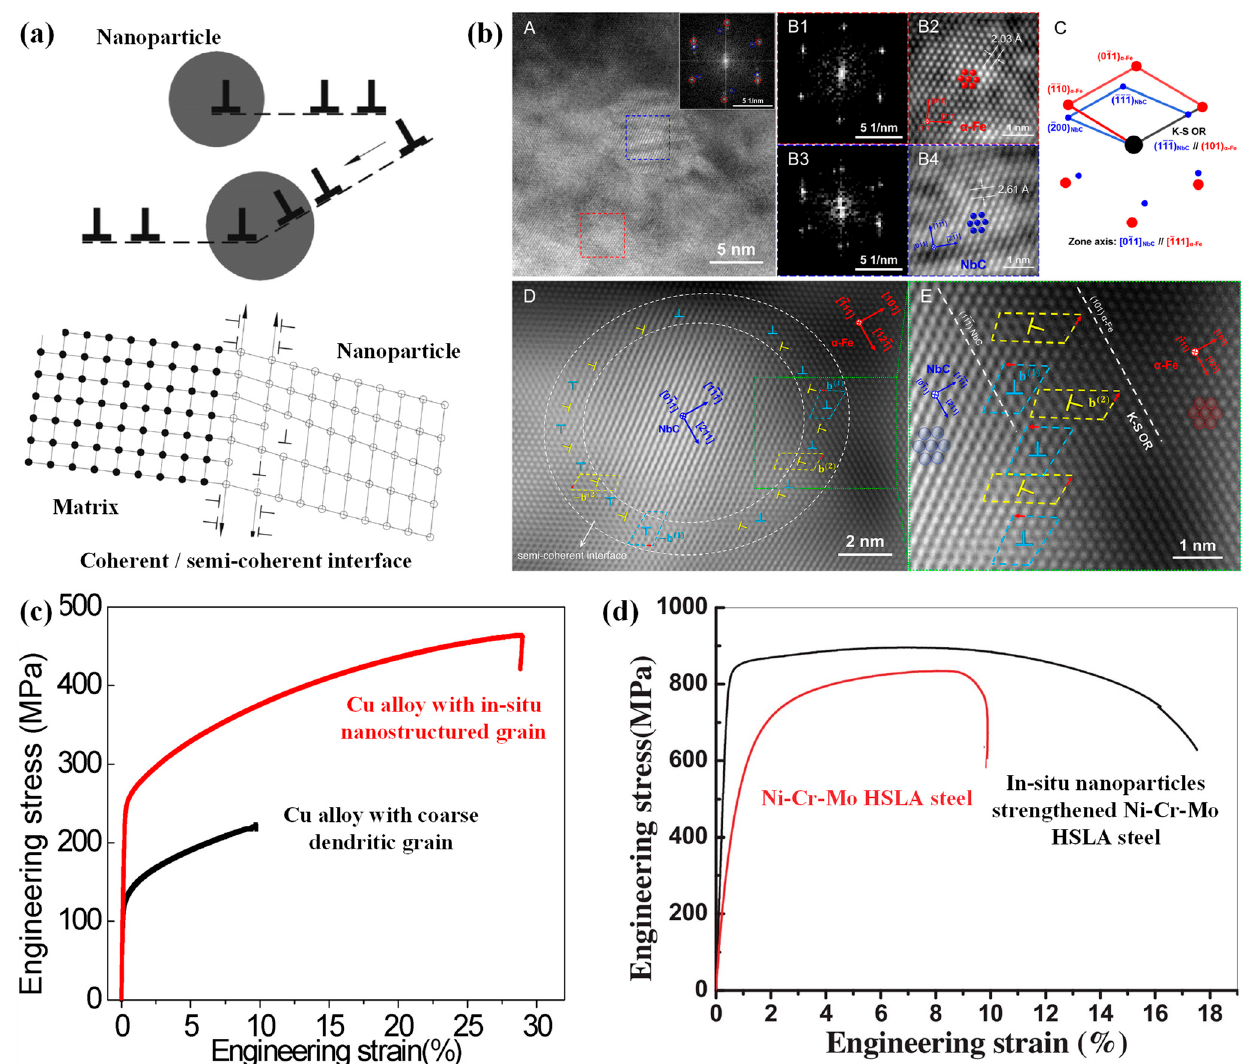
Figure 14. ( a ) Strengthening mechanisms of the nanoparticles being coherent/semi-coherent to the matrix, reprinted with permission from ref. [74], 2022, Elsevier; ( b ) misfit dislocation at a NbC/ α -Fe semi-coherent interface alone the 010 // 111 directions (A, HRTEM image of a typical NbC and the surrounding α -Fe; B1 (FFT) and B2 inversed FFT (IFFT) of α -Fe in the red square; B3 (FFT) and B4 (IFFT) of NbC in the blue square; C, Schematic summarizing the diffraction patterns for the orientation relationship (OR) between the NbC and α -Fe; D, NbC/ α -Fe interface with high-density misfit dislocations; E, Enlarged image of the green dotted zone in D), reprinted with permission from ref. [71], 2022, Elsevier; ( c ) tensile engineering stress-strain curves of Cu alloy with/without in situ nanoparticles, reprinted with permission from ref. [76], 2022, Elsevier; ( d ) tensile engineering stress-strain curves of in situ nanoparticles strengthened HSLA steel and comparison steel, reprinted with permission from ref. [69], 2022,